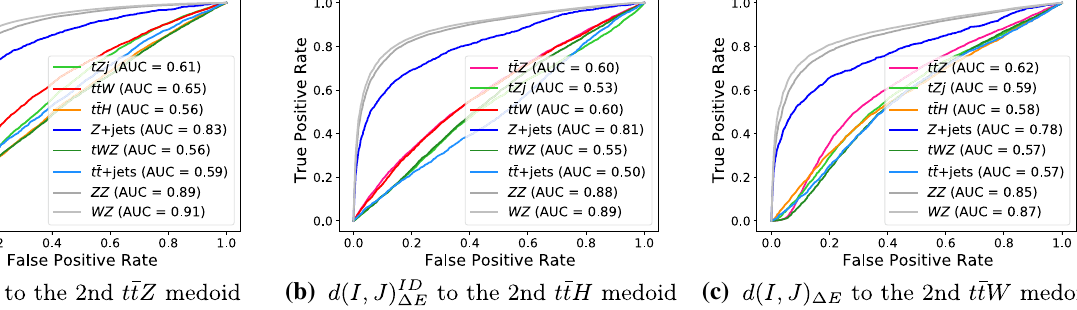
cesssample. Foreachcase,theROC evaluates thetaskofdistinguishing the process represented by the medoid reference from the remaining processes and the corresponding area under the curve (AUC) is